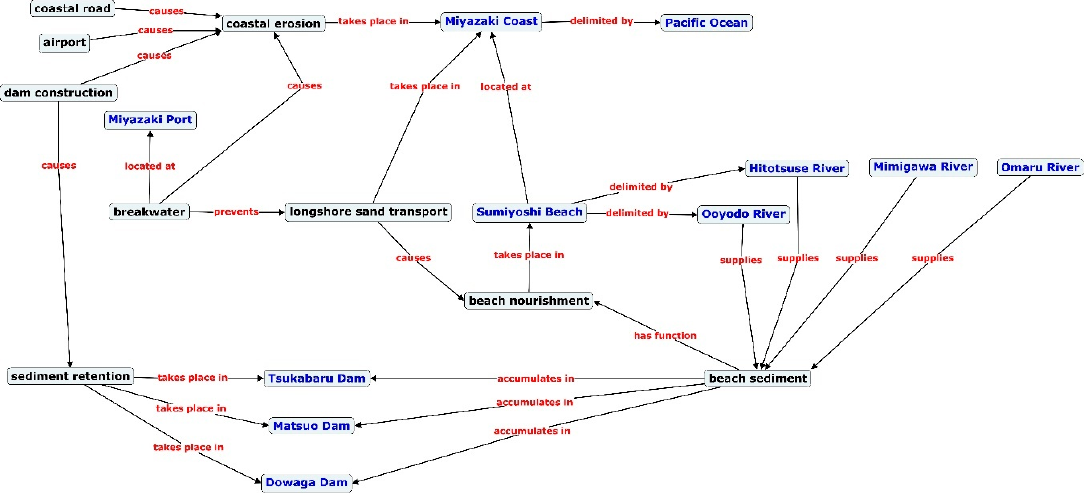
Figure 7. Semantic network of the terms associated with the Omaru and Mimigawa rivers.